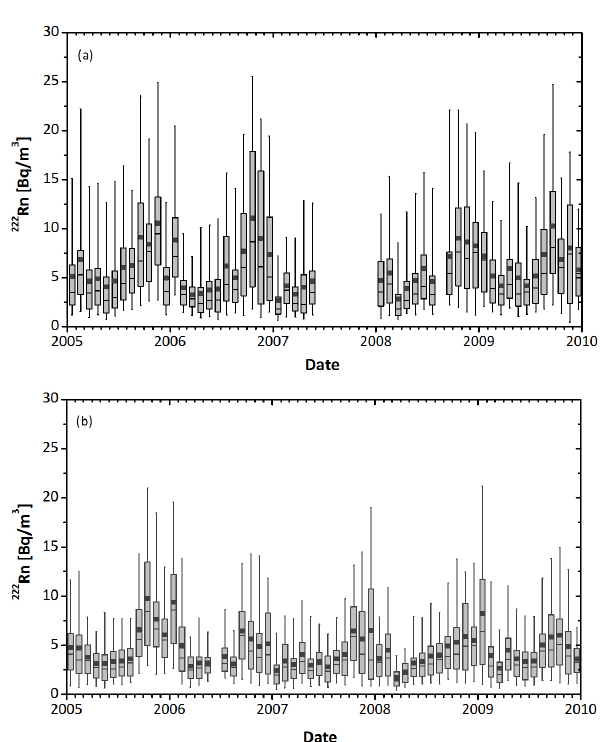
Figure 4. Box-and-whisker plot of monthly 222 Rn concentration recorded in the near-ground atmosphere of Krakow (a) and Heidel- berg (b) between January 2005 and December 2009. Marked per- centiles represent the 5, 25, 75 and 95% confidence interval; black squares represent medians; and horizontal lines represent mean val- ues.